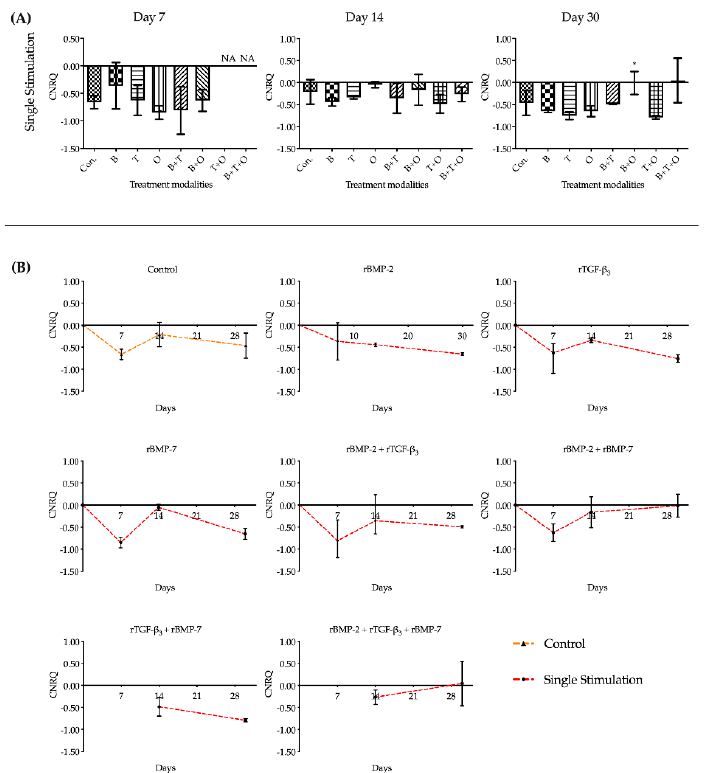
Figure 5. The analyses of the relative expression levels of collagen type X alpha 1 ( Col10 α 1 ). The results were presented as calibrated normalized relative quantity (CNRQ). ( A ) Comparisons between each experimental group under different stimulation modes and the corresponding control group at day 7, 14 and 30 using one-way ANOVA. ( B ) Comparisons between the experimental groups where growth factors were applied continuously and the corresponding 48 h withdrawal groups at day 7, 14 and 30 using one-way ANOVA. Con.= control group, B= rBMP-2 treated group, T = rTGF- β 3 treated group, O = rBMP-7 treated group, B + T = rBMP-2 + rTGF- β 3 treated group, B + O = rBMP-2 + rBMP-7 treated group, T + O = rTGF- β 3 + rBMP-7 treated group, B + T + O= rBMP-2 + rTGF- β 3 + rBMP-7 treated group. Number of replicates ( n ) = 6. We defined p < 0.05 as a statistically significant difference. * p < 0.05. In ( A ) statistical significance is expressed between each group and the control group (normal medium), while in ( B ) it is